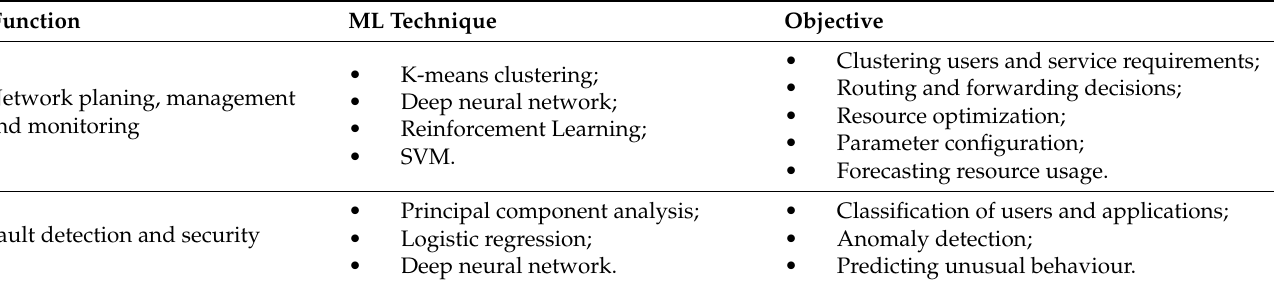
Table 1. Network functions and relevant ML techniques